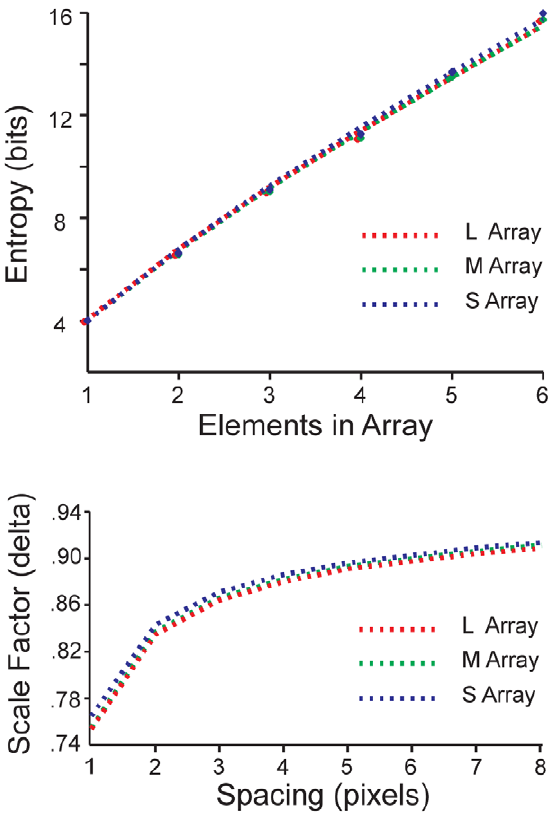
Figure 2. Information in arrays of L, M, and S cones. (Top) Information in N cones of a given type, I N , plotted as a function of N for L, M, and S cone arrays. Array spacing is set here to 1 pixel (46 pixels=one degree of visual angle). The best-fitting power law ( I N ~ I 1 N d ) is also shown. For the minimal spacing of pixels in our images ( d =1), d =0.75 in each channel. Using 50 randomly selected images from the van Hateren database [48] similarly gave d =0.72. (Bottom) d is plotted as a function of spacing ( d ) for each cone